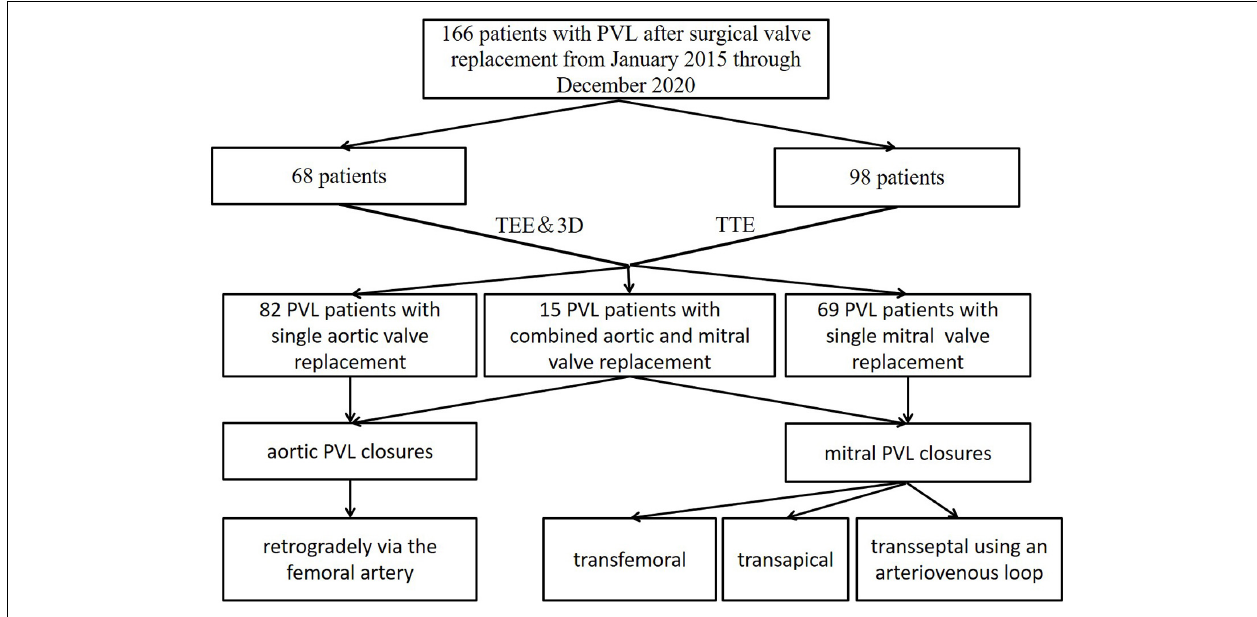
FIGURE 1 | Patient flow diagram of the transthoracic echocardiographic (TTE) group and the transesophageal and 3-dimensional group.